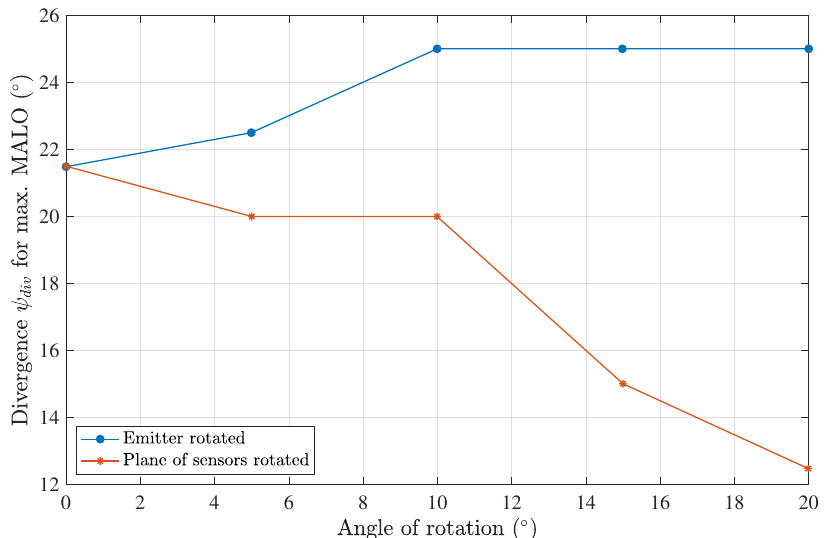
Figure 15. Divergence for the maximum MALO as a function of the rotation angle, considering a harbor II water type, a Tx–Rx distance of 0.5m and a 7-lens